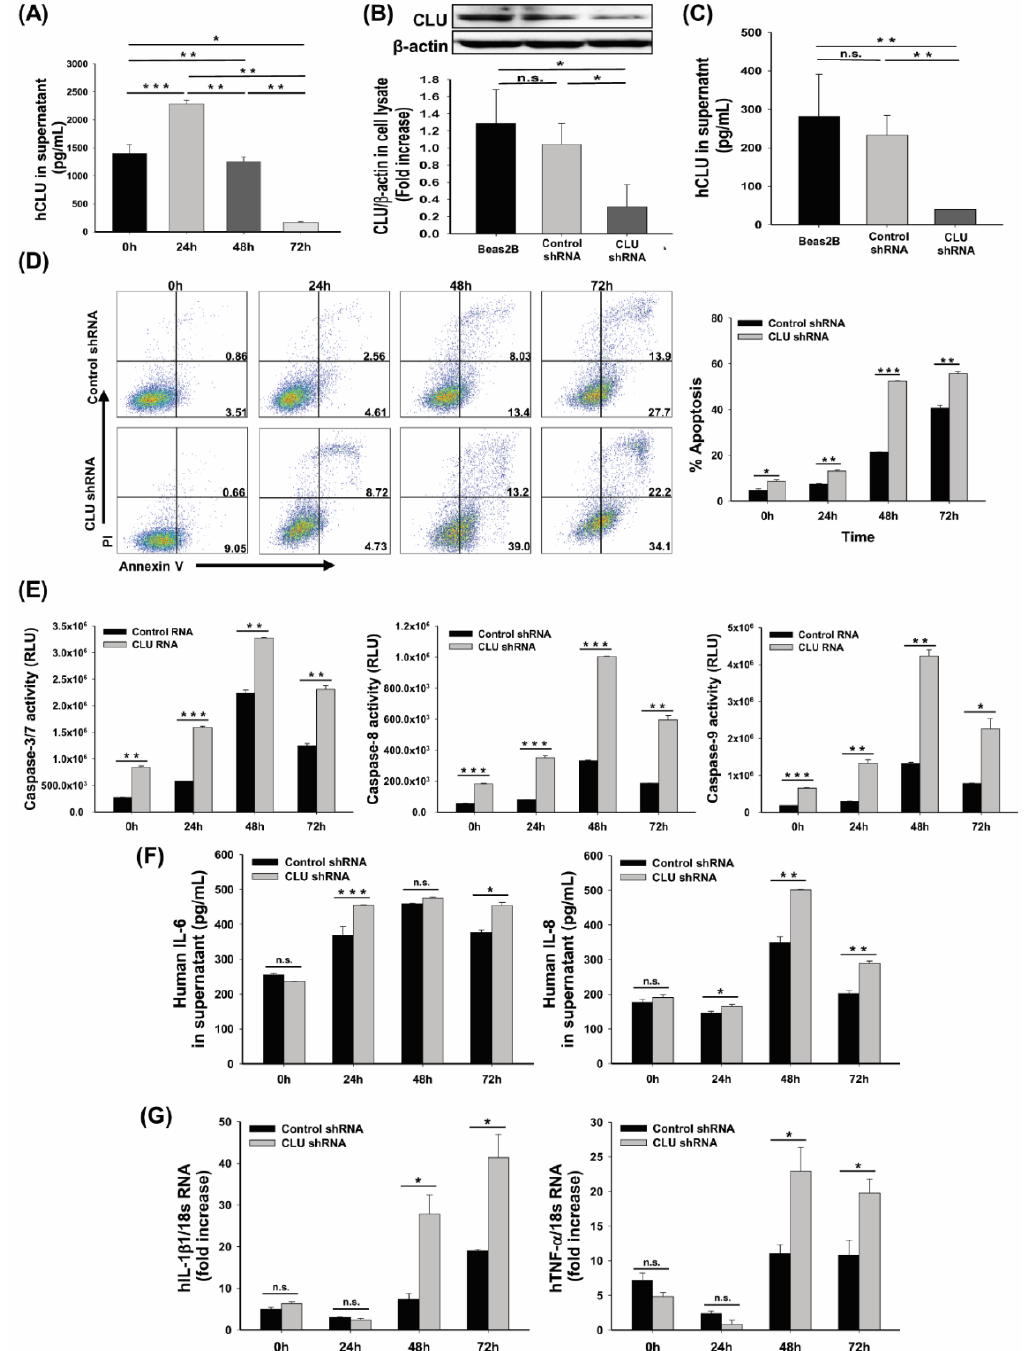
Figure 3. Hyperoxia induces apoptosis and inflammation in human airway epithelial cells. Beas-2B cells were cultured in 95% O 2 and 5% CO 2 , for up to 72 h. ( A ) Clusterin (CLU) levels were measured in the supernatants by ELISA. Beas-2B cells were transfected with lentiviral CLU shRNA or control shRNA and ( B ) Western blotting and ( C ) ELISA showed the efficacy of shRNA knockdown of CLU in transformed Beas-2B cells. ( D ) Cell apoptosis was measured by annexin V/PI staining. Annexin V + PI − and annexin V + PI + cells were considered apoptotic cells. ( E ) Caspase-3/7, -8 and -9 activities were determined by Caspase-Glo ® 3/7 assay. ( F ) IL-6 and IL-8 levels were measured in the supernatant by ELISA. ( G ) The mRNA levels of IL-1β and TNF-α were detected by real-time PCR. Values represent the mean ± SEMs of three independent experiments. n.s. = not significant; * p < 0.05, ** p < 0.01, *** p < 0.001. RLU = relative luminescence units.